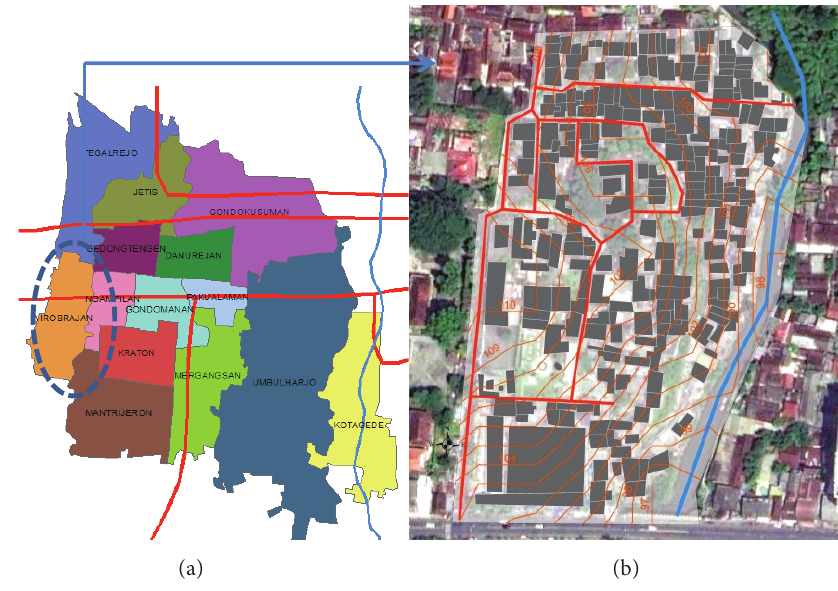
Figure 1. (a) The map of Yogyakarta; (b) The map of Kampong